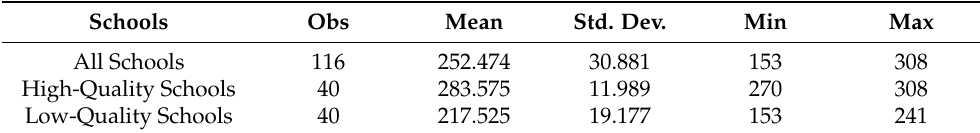
Table 1. Descriptive statistics for Measure 1: merit value. Schools Obs